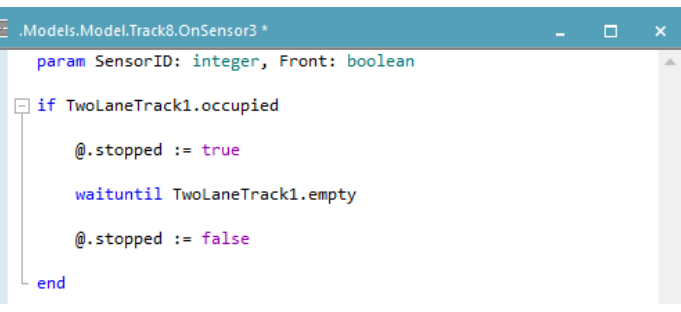
Figure 11. Connector method for stopping and starting the vehicle at the crossing.